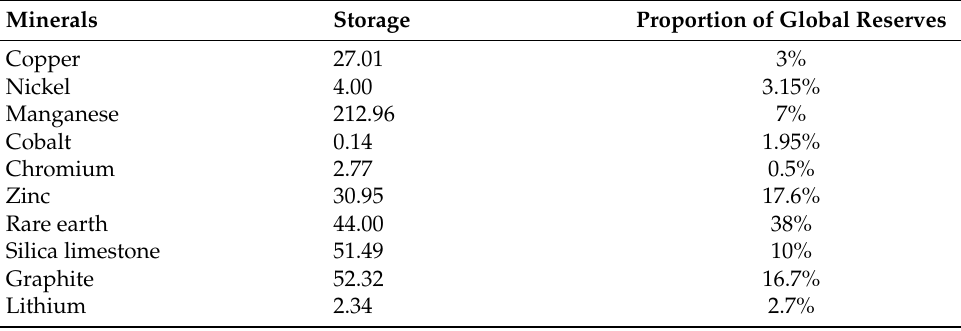
Table 2. Selected mineral reserves in China in 2020 (unit: MT) (Data Source: [27]).